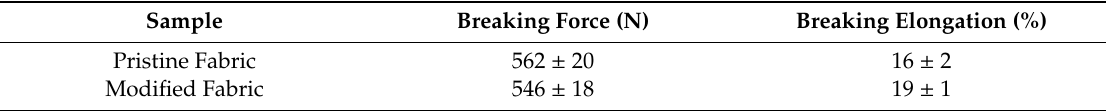
Table 1. Breaking force and elongation of pristine fabric and modified fabric.